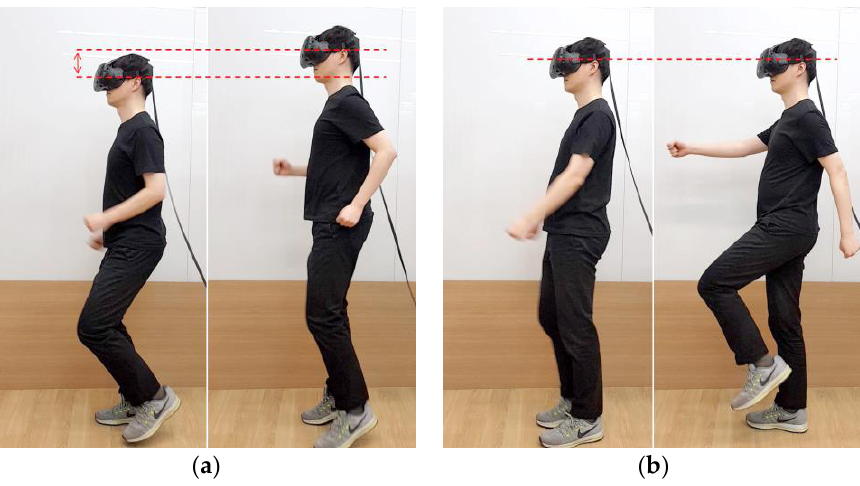
Figure 4. This shows the WIP motions we have categorized. The red dotted line indicates the y position of the Head Mounted Display (HMD). ( a ) A “ jog-in-place ” motion. This motion moves the HMD up and down. ( b ) A “ march-in-place ” motion. In this motion, the movement of the HMD is not large.